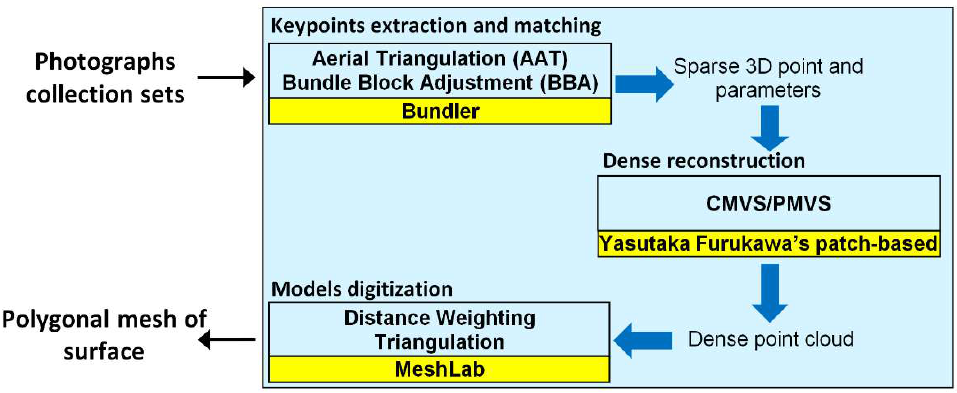
Figure 11. Flowchart of the main steps of the surface reconstruction algorithm.